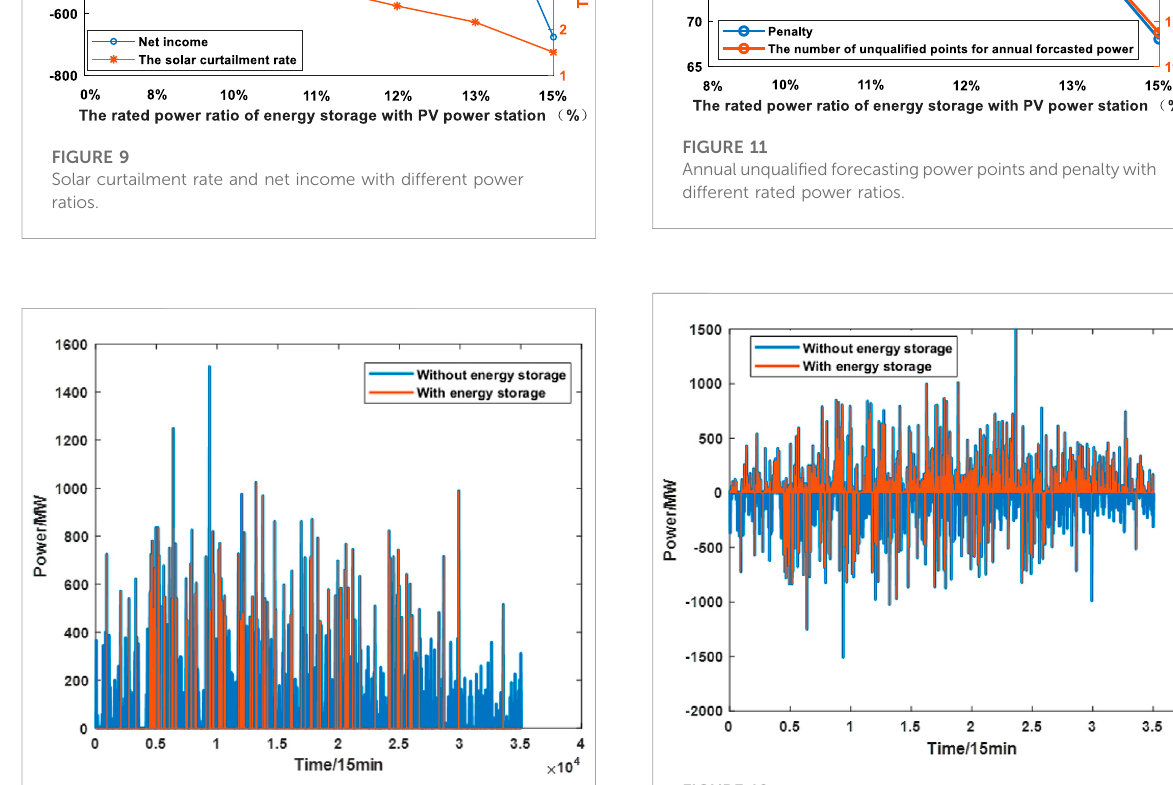
FIGURE 12 Deviation between forecasting and actual